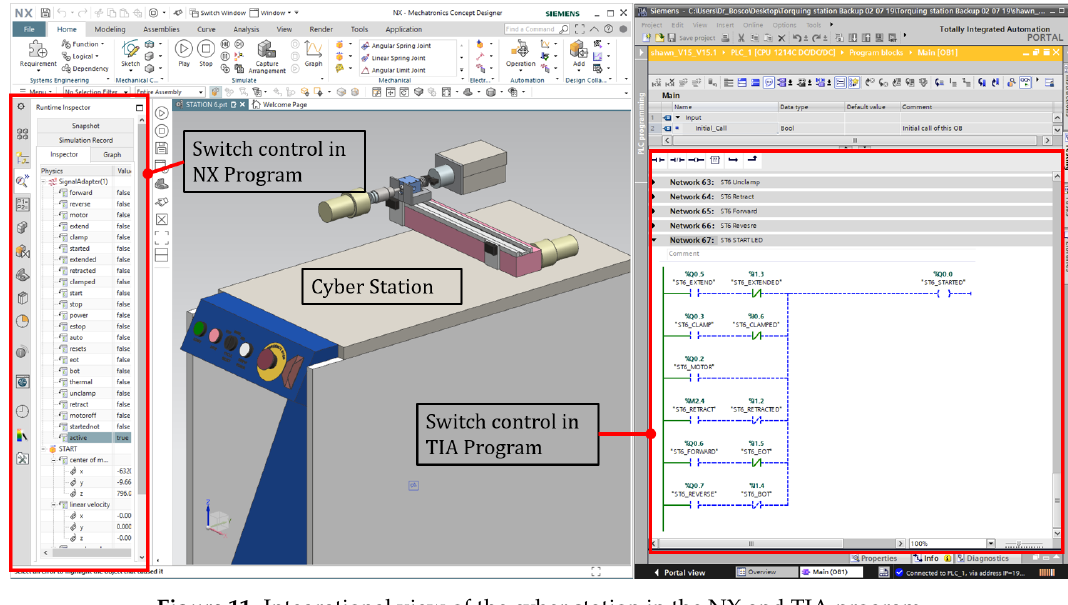
Figure 11. Integrational view of the cyber station in the NX and TIA program.